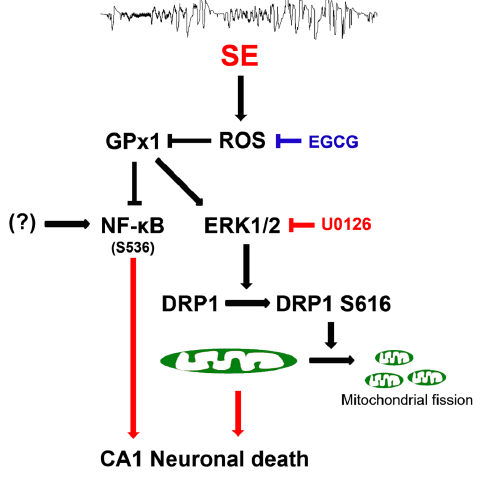
Figure 11. Scheme of the underlying mechanisms of the neuroprotective effects of EGCG against SE.